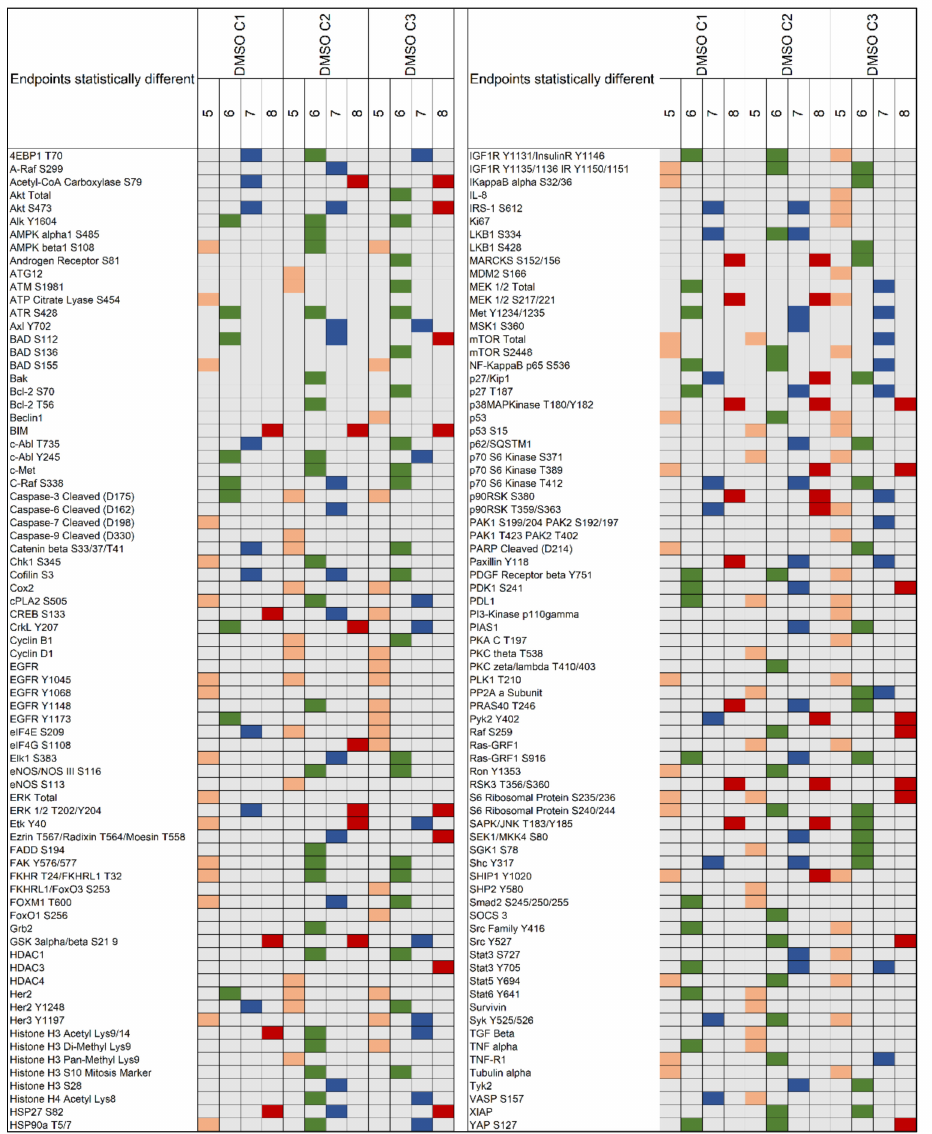
Figure 4. For each cell line and DMSO concentration (C1 = 0.0008%, C2 = 0.002%, and C3 = 0.004%, respectively), a two-tailed Kruskal Wallis rank test was used to capture changes across timepoints ( n = 5). Proteins that emerged as statistically significant in five (orange), six (green), seven (blue), or all eight (red) cell lines are shown in the matrix. A total of 150 proteins met the criteria and are